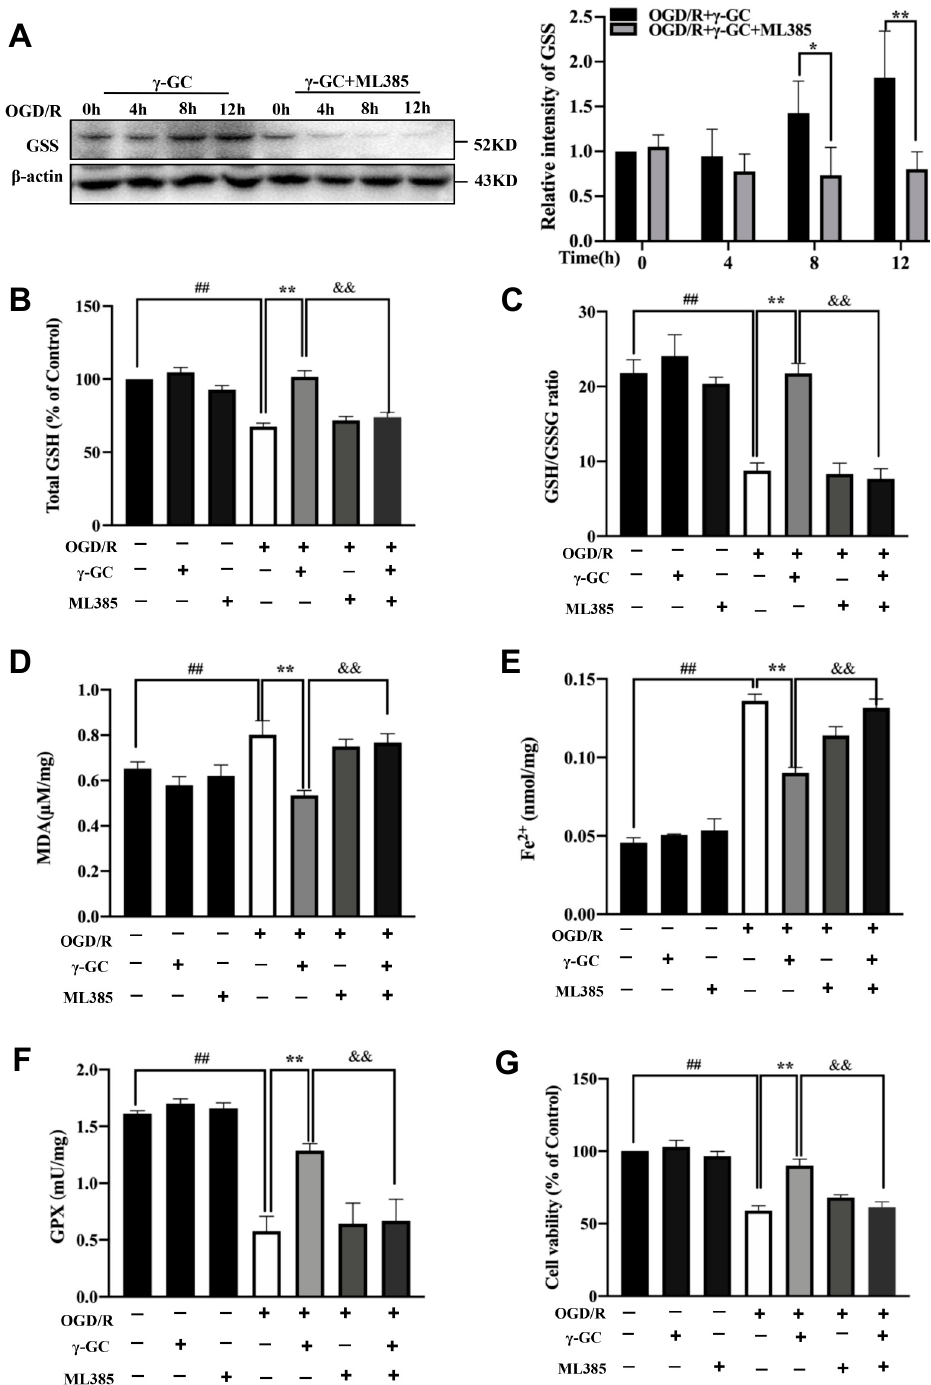
Figure 6. γ -GC increases the protein level of GSS and GSH contents in PC12 cells through activating Nrf2. PC12 cells were pretreated with Nrf2 inhibitor ML385 (2 µ M) 2 h before OGD and then were treated with γ -GC (3.5 mM) at the onset of reoxygenation for the indicated time. ( A ) Immunoblot- ting was performed to measure the protein level of GSS. ( B , C ) Intracellular GSH content and the GSH/GSSG ratio were determined. ( D – G ) The MDA and Fe 2+ levels, GPX enzyme activity and cell viability were detected using commercial detection kits. Data are mean ± SD (n = 3), ## p < 0.01 versus control group, * p < 0.05 and ** p < 0.01 versus OGD/R cells or the group indicated, && p < 0.01 versus OGD/R+ γ -GC cells.